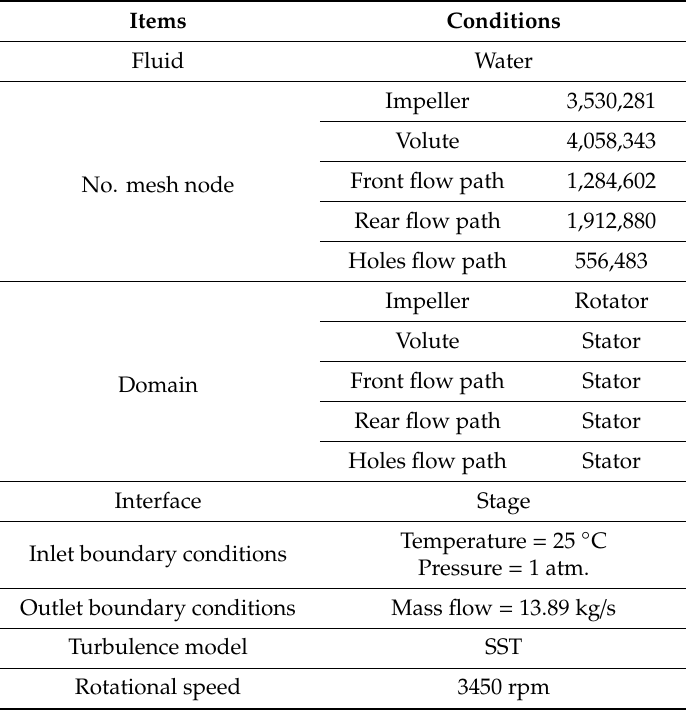
Table 3. CFD analysis boundary conditions of Type B pump